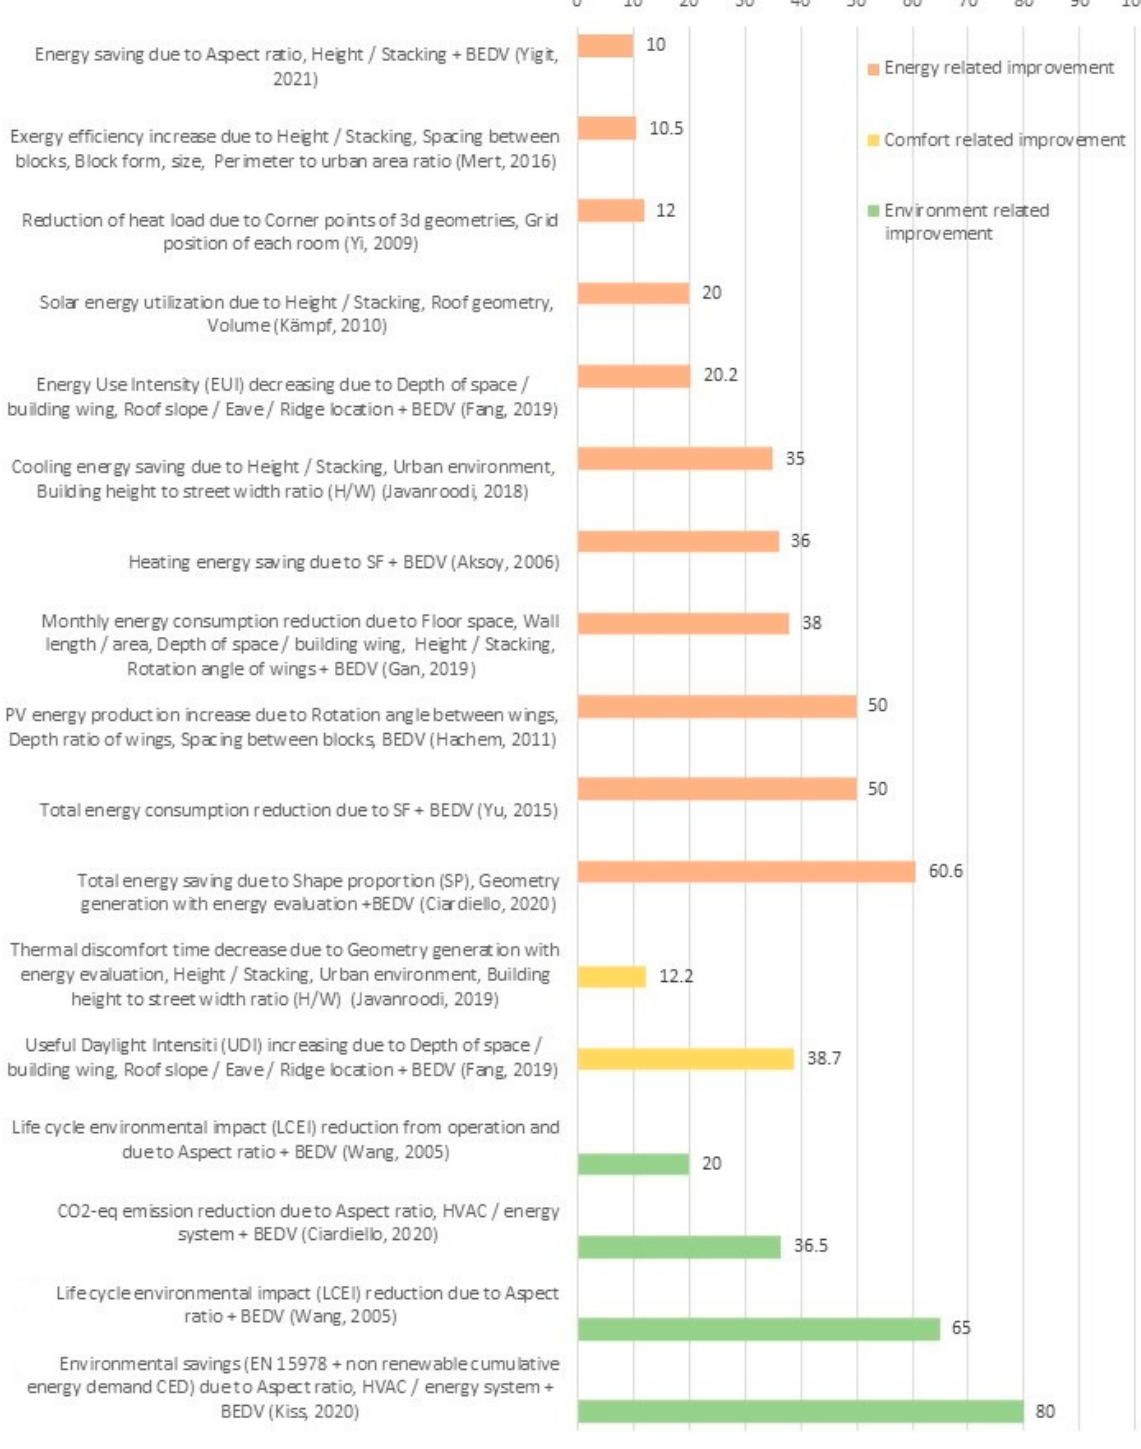
Figure 7. Improvements (%) in energy, comfort, and environmental performance, due to BGDV, BEDV and HVAC system variations in the reviewed